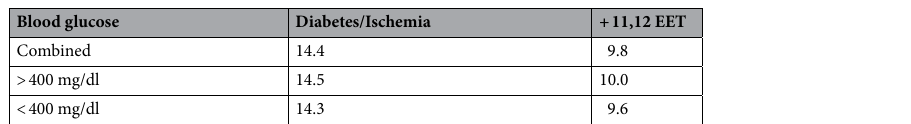
Table 1. Comparison of the day of wound closure in mice exceeding blood glucose level of 400 mg/dl and those below 400 mg/dl.